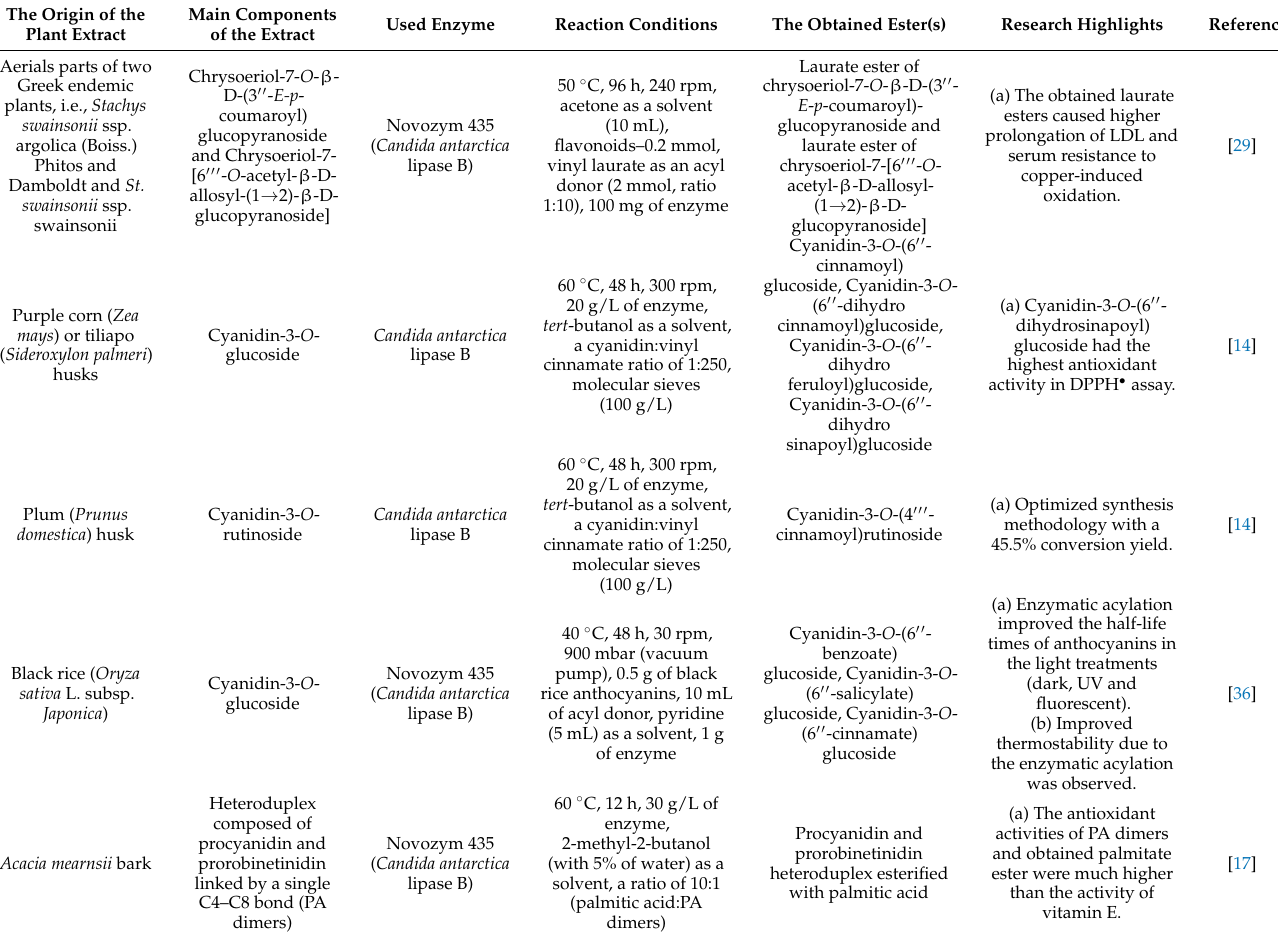
Table 3. Other plant extracts used in enzymatic modifications of phenolic